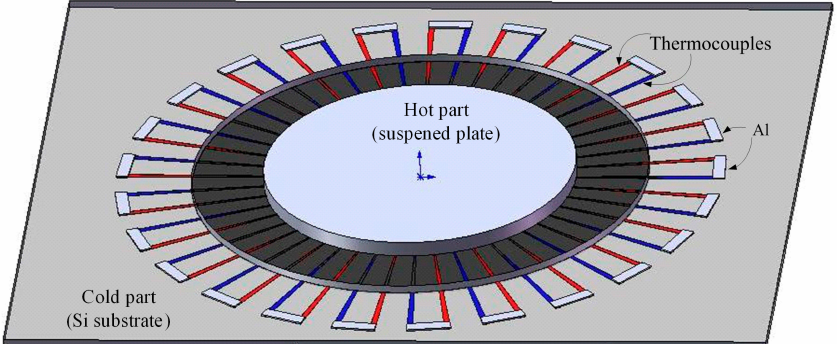
Figure 1. Structure of an energy harvesting cell.